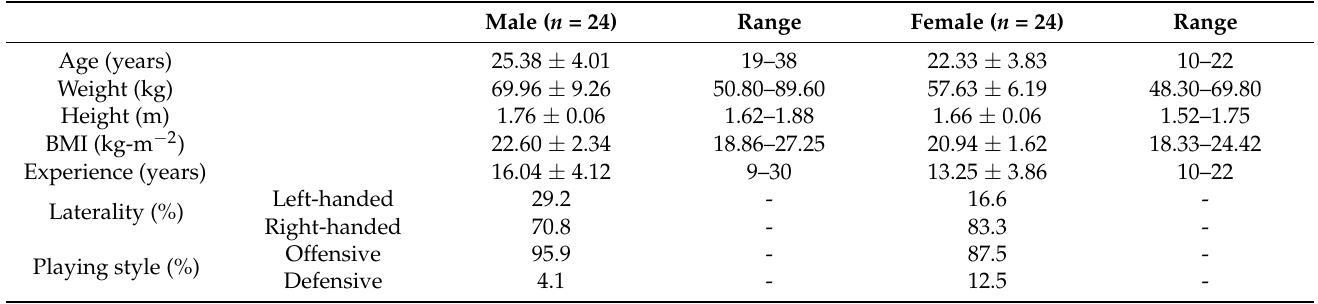
Table 1. Descriptive characteristics of the participants ( n =